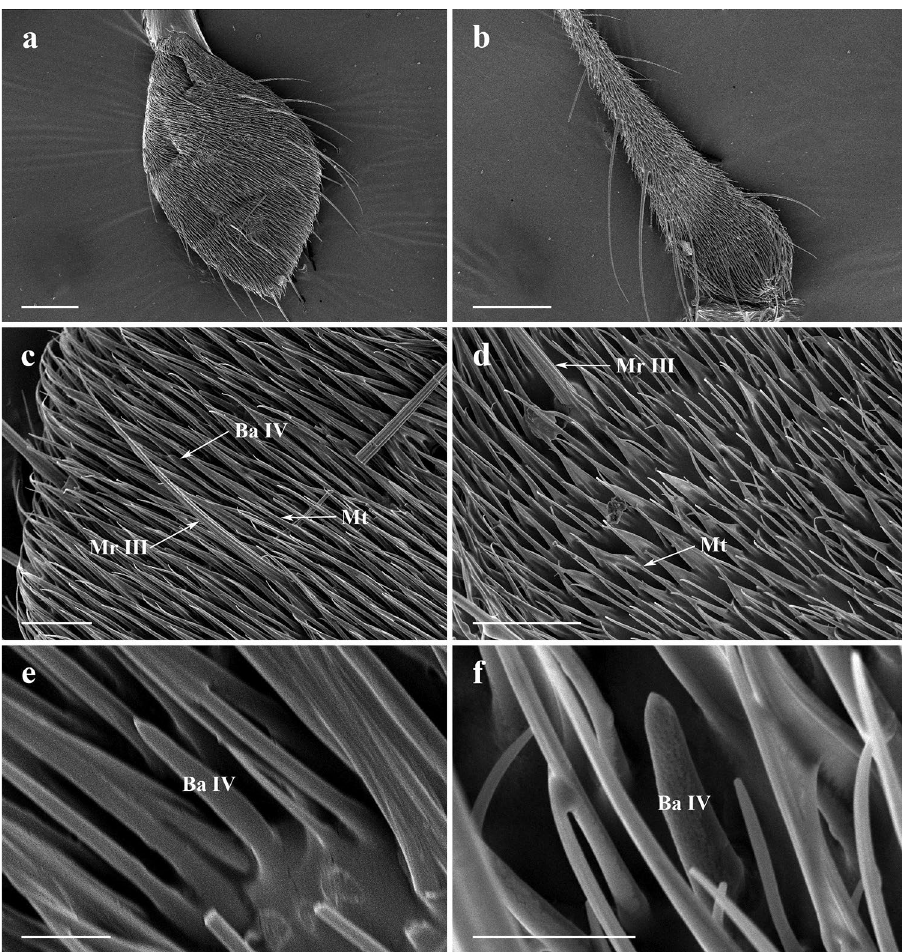
Figure 6. SEM micrographs of features on maxillary palps of Lispe orientalis and L . pygmaea . ( a ) Posterior surface on maxillary palp of male L . orientalis . ( b ) Posterior surface on maxillary palp of male L . pygmaea . ( c ) Different types of sensilla on maxillary palp of male L . orientalis . ( d ) Different types of sensilla on maxillary palp of male L . pygmaea . ( e ) Subtype IV basiconic sensilla of male L . orientalis . ( f ) Subtype IV basiconic sensilla of L .